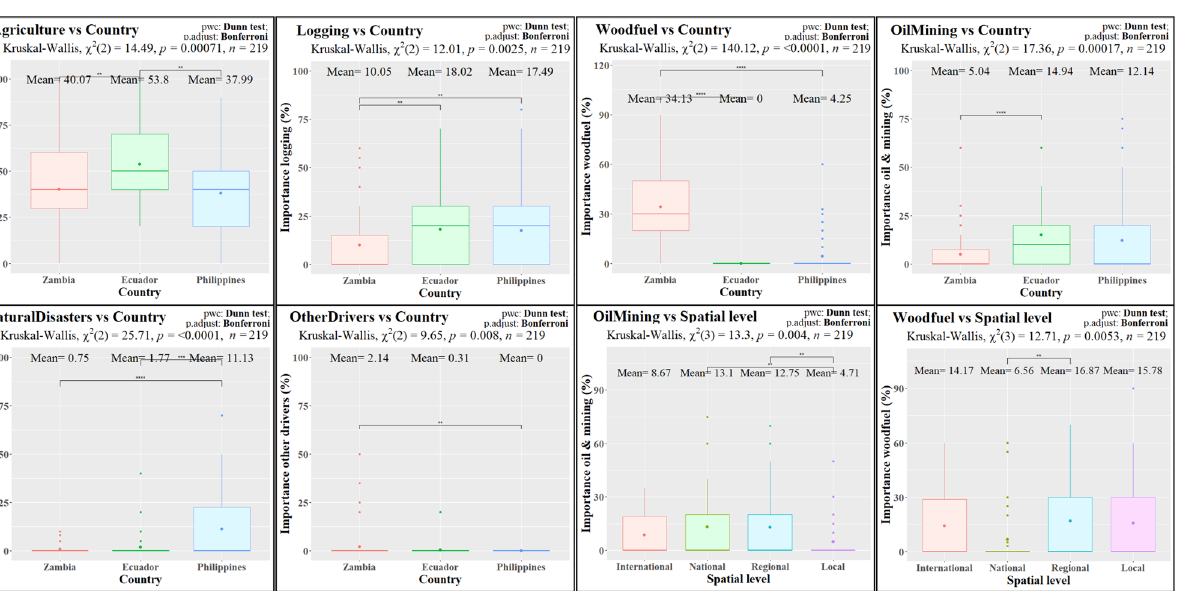
Figure 3. Results of the Kruskal–Wallis and Dunn tests across countries and spatial levels for the variables related to the expected importance of driver categories. Only tests with statistically significant results are shown. Boxplots including mean values (Mean), chi square statistic ( χ 2 ), p-values (p) and number of observations (n) of the Kruskal–Wallis tests and p-adjustment (p.adjust) and p-scores (sign, ****: < 0.0001, ***: < 0.001, **: < 0.01, *: < 0.05, ns not significant [> 0.05]) for the Dunn pairwise comparisons